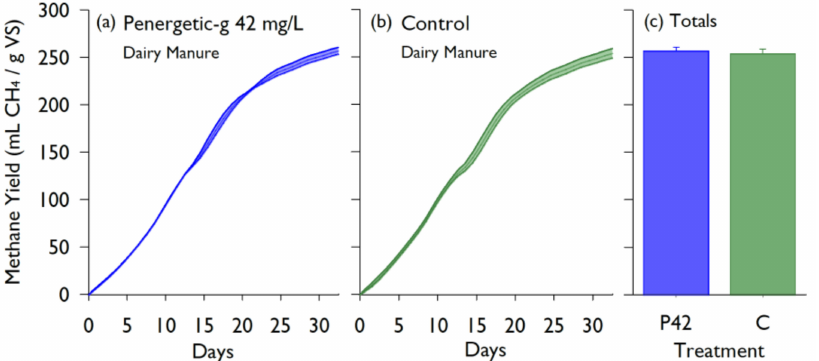
Figure 5. Cumulative methane yields over time from dairy manure BMP batch cultures containing the Penergetic-g ® (P) additive at 42 mg / L ( a ), or without additive ( b ). Each timeseries shows the mean ± standard deviation (n = 3). The total yield for all treatments are compared in the bar graph, with the error bars showing standard deviation ( c ). Yields are scaled by volatile solids